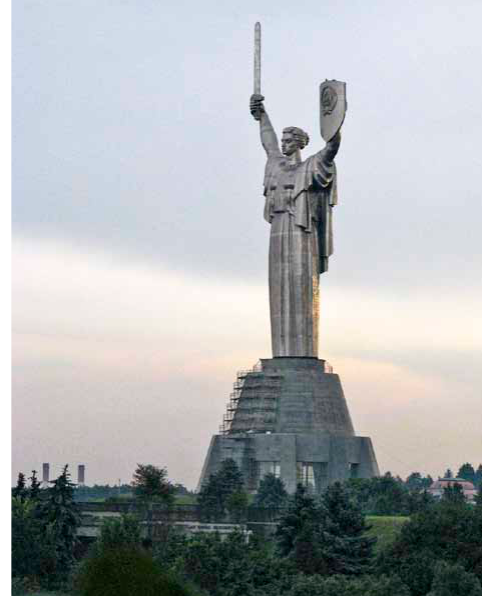
fig. 2. “Mother armenia” monument in Yerevan. r. Čepaitienė photo